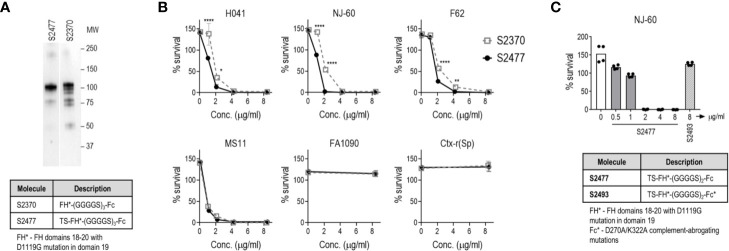
Improved stability and efficacy of FH*/Fc bearing two amino acids (TS) at the N-terminus (S2477) in vitro. (A) S2477 shows fewer degradation products compared to S2370. Western blot of purified S2477 (lane 1) and S2370 (lane 2) using anti-human IgG alkaline phosphatase as the detection reagent. Note that irrelevant lanes between lanes 1 and 2 have been excluded. MW, molecular weight (kDa). (B) S2477 (TS-FH*-(G4S)2/Fc) and S2370 (FH*-(G4S)3/Fc) (concentrations indicated on the X-axis) were incubated with sialylated strains H041, NJ-60, F62, MS11, FA1090, and Ctx-r(Sp) and complement and survival at 30 min (relative to 0 min) was measured in a bactericidal assay. Comparisons were made by two-way ANOVA. *P < 0.05; **P < 0.01; ****P < 0.0001. (C) Complement-dependent bactericidal efficacy of S2477 against N. gonorrhoeae strain NJ-60. Negative controls included bacteria incubated with complement alone (open bar on left) and bacteria incubated with 8 µg/ml S2493 (TS-FH*-(G4S)2/Fc-D270A/K322A (complement-inactive Fc mutations); hatched bar on right).